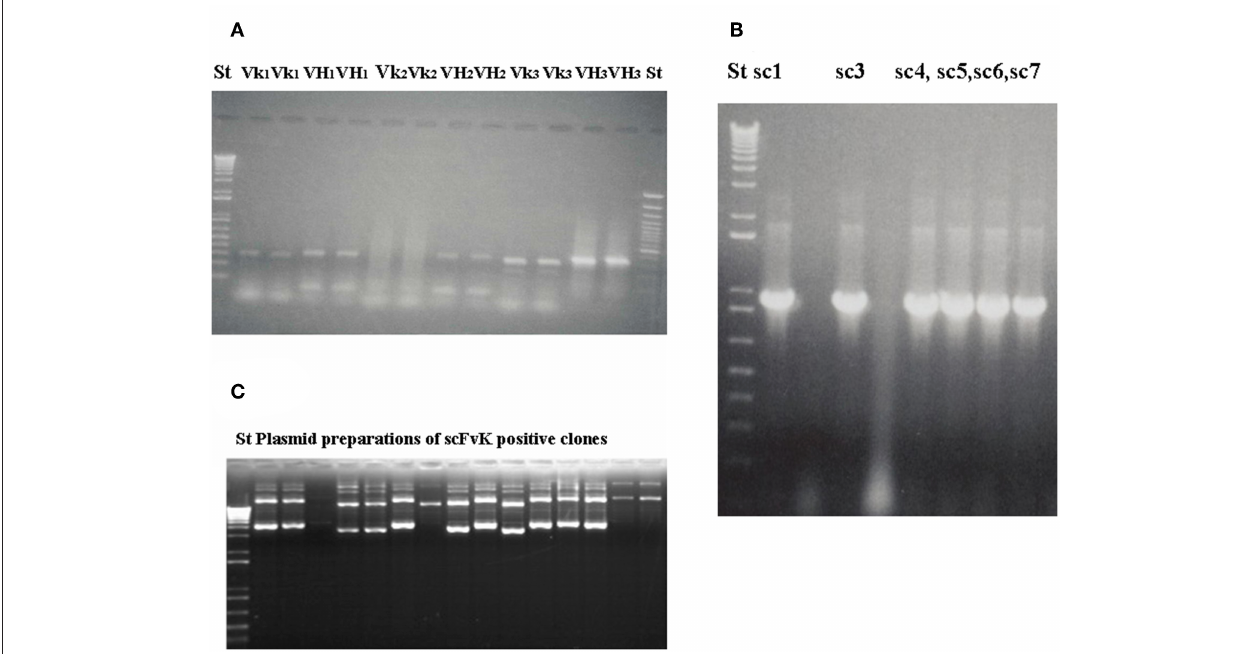
FIGURE 3 | Gelelectrophoresis shows amplified immunoglobulin variable heavy and light chain gene regions and the constructed scFv antibody fragment. Preparative gel electrophoresis picture shows representative results with two parallels of amplified immunoglobulin VH and V κ gene regions (A) from malignant melanoma cases ( n = 3). Two standard marker lanes on the left and the right side help to identify the DNA Ig variable gene regions with their expected size (VH: 360 bp, V κ : 340bp) that would serve for the scFvK gene construction in the course of three step PCR reactions and purification. ScFvK was ligated into the phagemid vector for bacterial transformation and library generation. Molecular standards show the approximate sizes (800 bp) of the scFvK gene construct in the inserted clones. (A) and (B) are reproduced with permission from (22). QIAPrep plasmid minipreps of ScFvK inserted bacterial clones are ready for further analysis in terms of tumor binding (C) .